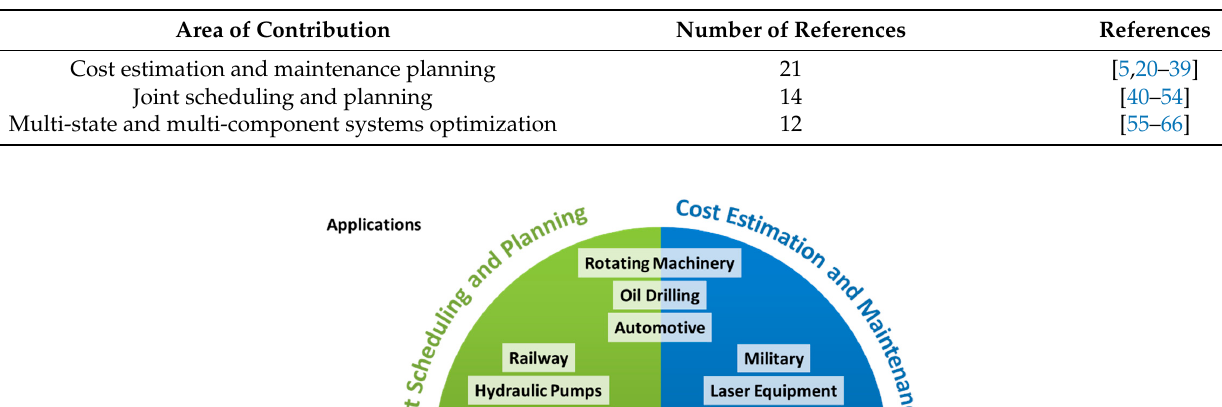
Figure 3. The applications for each area of contribution.